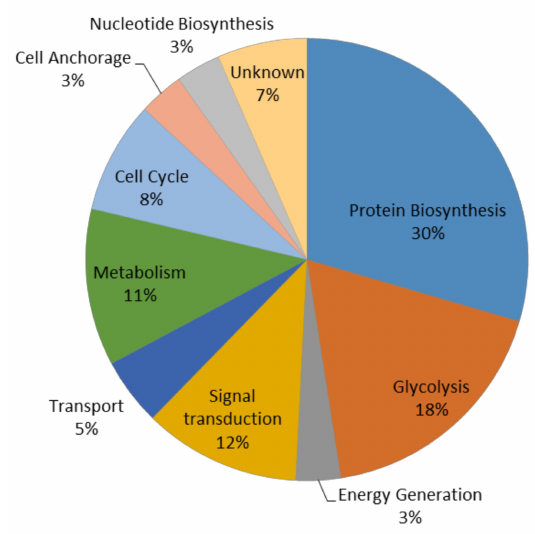
Figure 3. Gene ontology enrichment analysis of the molecular function of the di ff erentially regulated